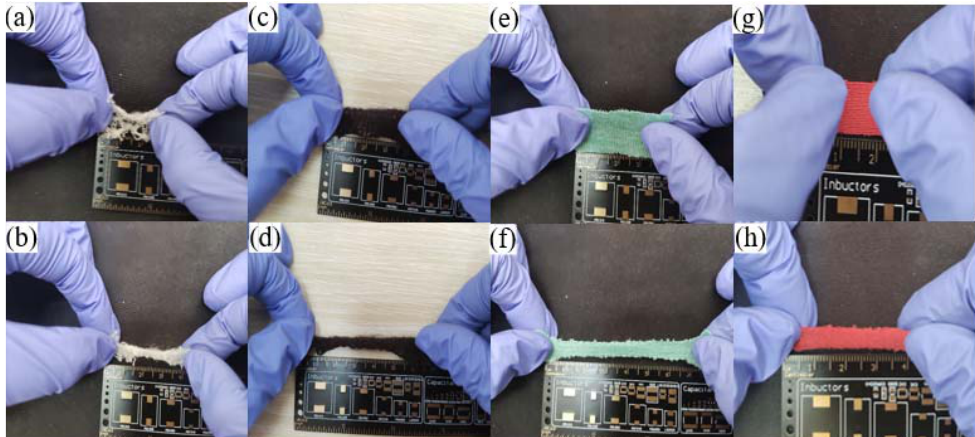
Figure 2. ( a ) Large-pore polyester fabric before stretching. ( b ) Large-pore polyester fabric